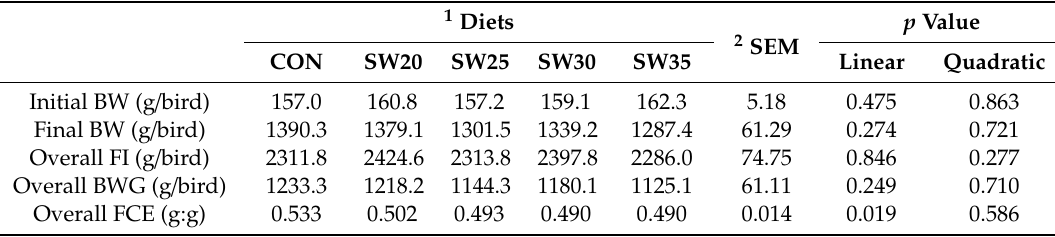
Table 3. Overall feed intake and overall growth performance of Cobb 500 broiler chickens o ff ered seaweed meal-containing